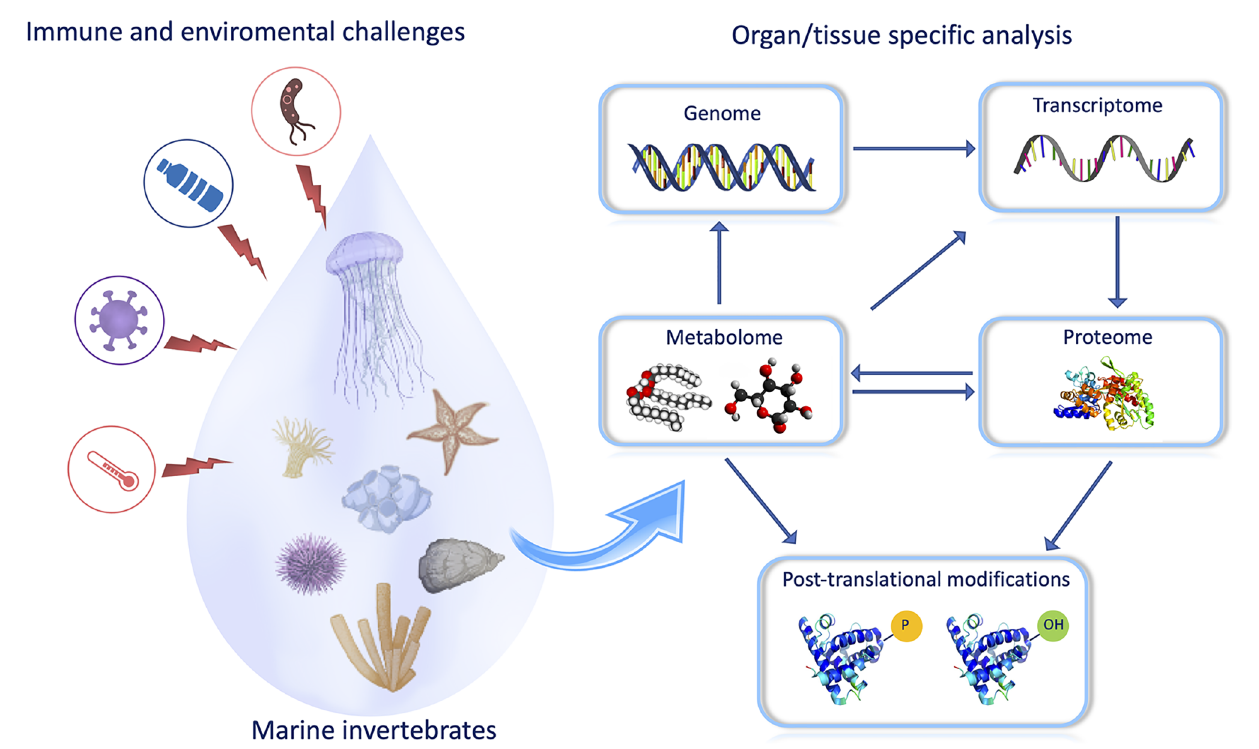
FIGURE 1 | The study of biological systems/processes has focused on one aspect of the system, such as genomics, transcriptomics, proteomics, and metabolomics. A synthesis of all information from these multi-omics approaches is required to provide a full understanding of an immune response. For example, the correlation of appearance and/or accumulation of some metabolites with protein modi fi cations could allow to build up the pathways engaged by animals to respond to a speci fi c challenge (T. Heinzl provided the scheme of the fi